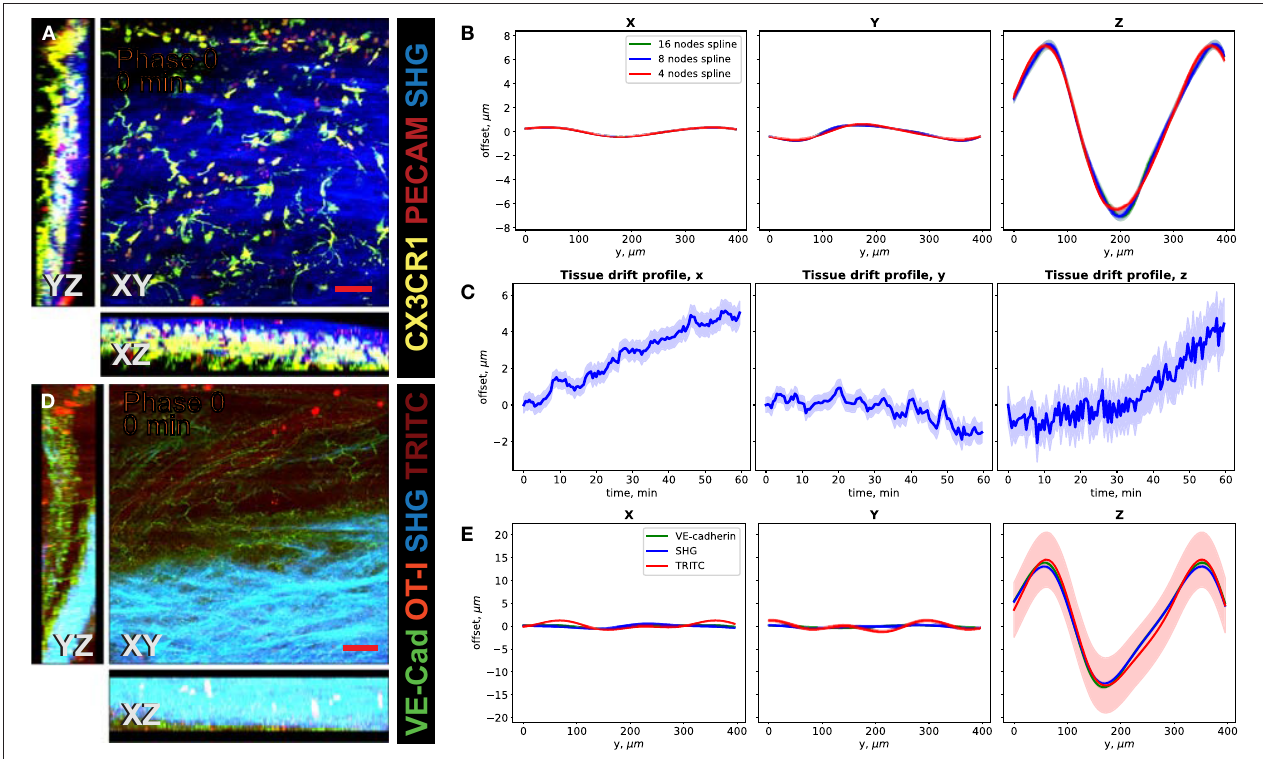
FIGURE 5 | Performance of the VivoFollow 2 system in the 2P-IVM imaging of the cervical spinal cord (SC) vasculature of mice. (A) Maximum intensity projection (MIP) of an image stack of the SC vasculature images in a CX3CR1-GFP//CCR2-RFP reporter mouse after iterative distortion correction. (B) Comparison of periodic motion profile reconstructed by the CX3CR1-GFP signal as reference landmark with 4-, 8-, and 16-node spline fit. The offset is shown as a function of position on the image for phase 0. (C) Tissue drift profile over 60min following the calibration stack acquisition (16min). (D) MIP of the SC vasculature images in VE-cadherin-GFP knock-in mice after distortion correction. (E) Comparison of periodic motion profile reconstructed by the VE-cadherin-GFP, Second Harmonic Generation (SHG), and low concentration of TRITC dextran vascular tracer signals. The significant Z motion is well-reconstructed in all cases. Color bands in (B,C,E) show standard error.